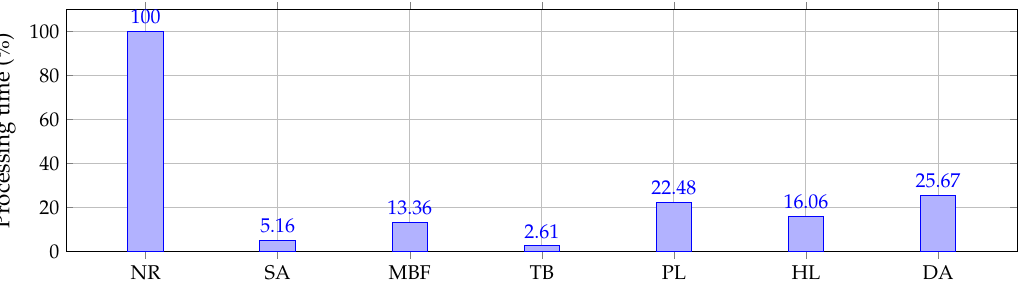
Figure 6. Processing time comparison for each studied power flow method compared with the classical Newton–Raphson method in the IEEE 85-bus